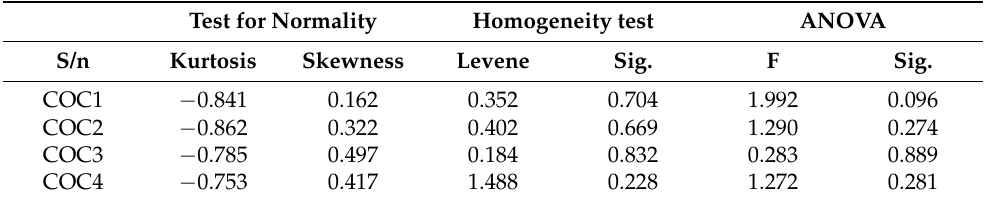
Table 12. One-way ANOVA for H&S considerations in conditions of contract. Test for Normality